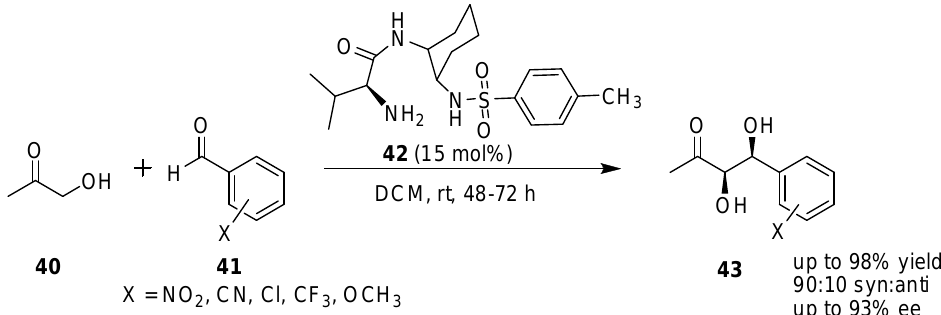
Scheme 18. Syn-aldol reaction using a chiral primary amine organocatalyst.